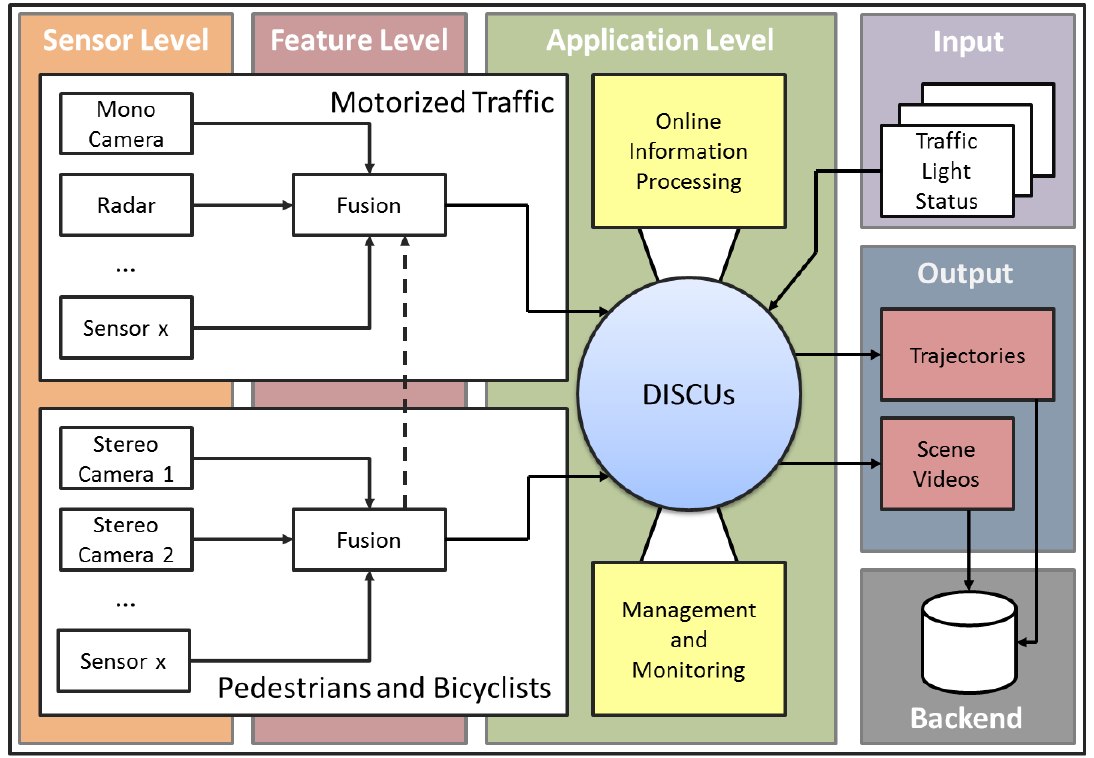
Figure 1: Functional architecture of AIM Research